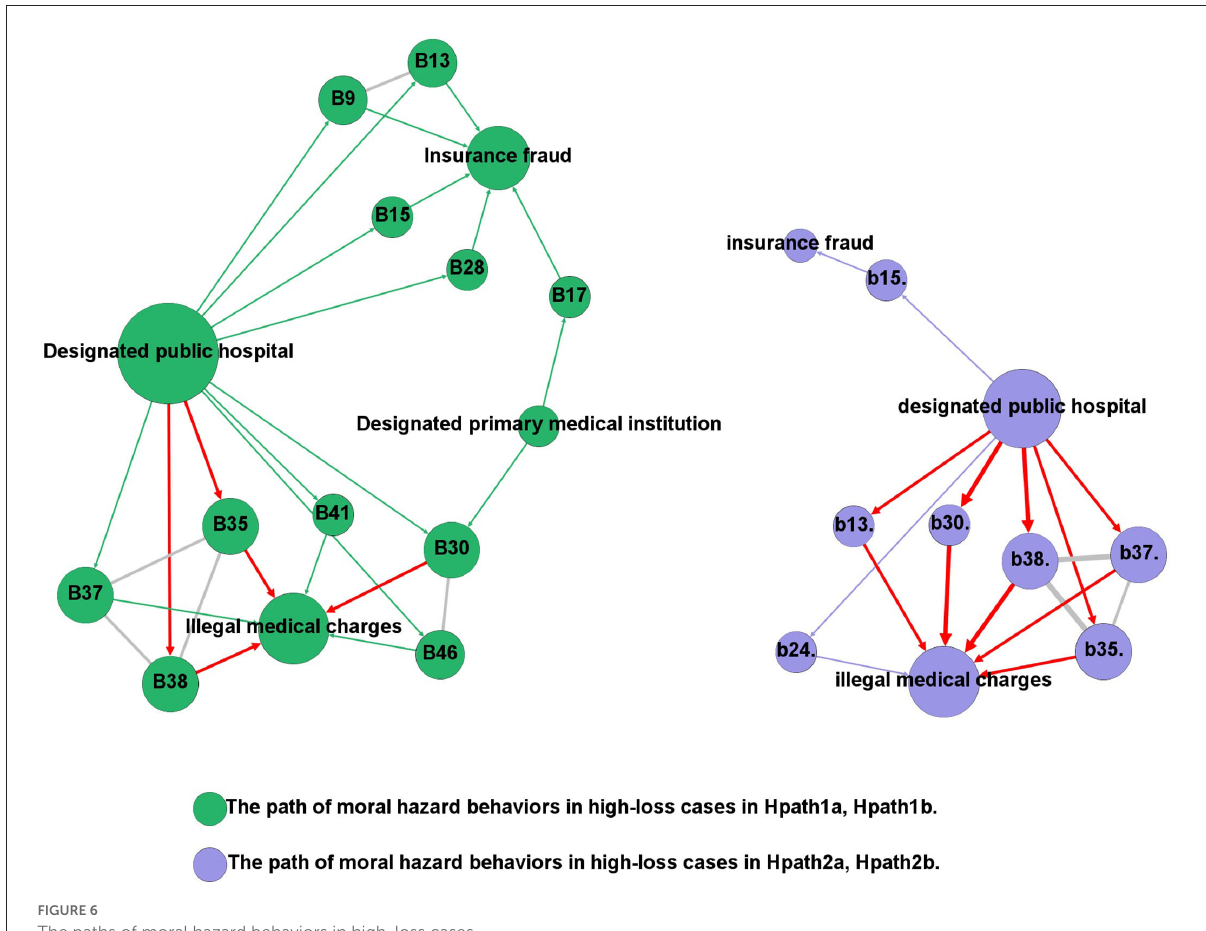
FIGURE6 The paths of moral hazard behaviors in high-loss